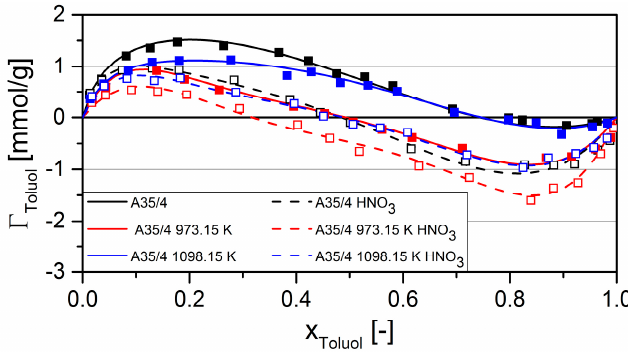
Figure 7. Excess isotherms of acetone-toluene at 298.15 K (symbols: measuring data (Table S6), lines: Redlich–Kister polynomials (Table S7)).